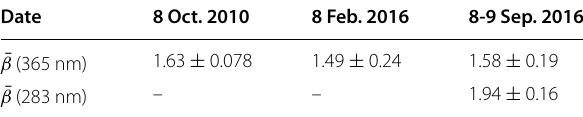
Table 2 Calibration factor β at 365 and 283 nm